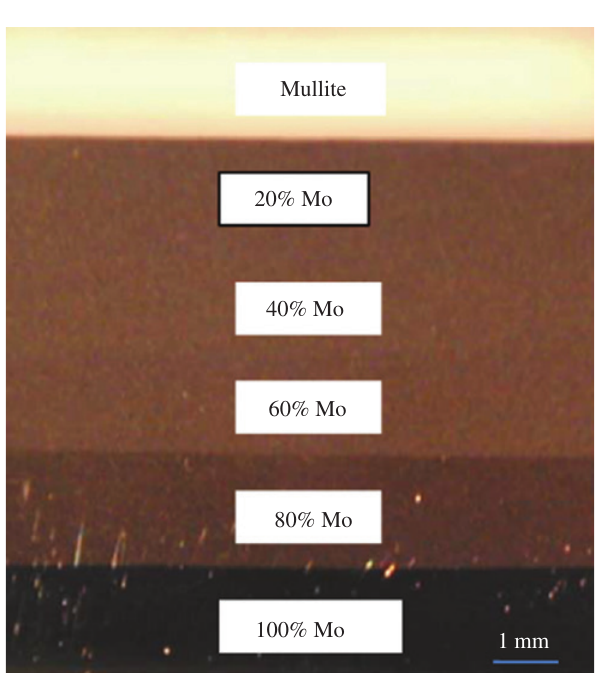
local strains, and alteration in carrier